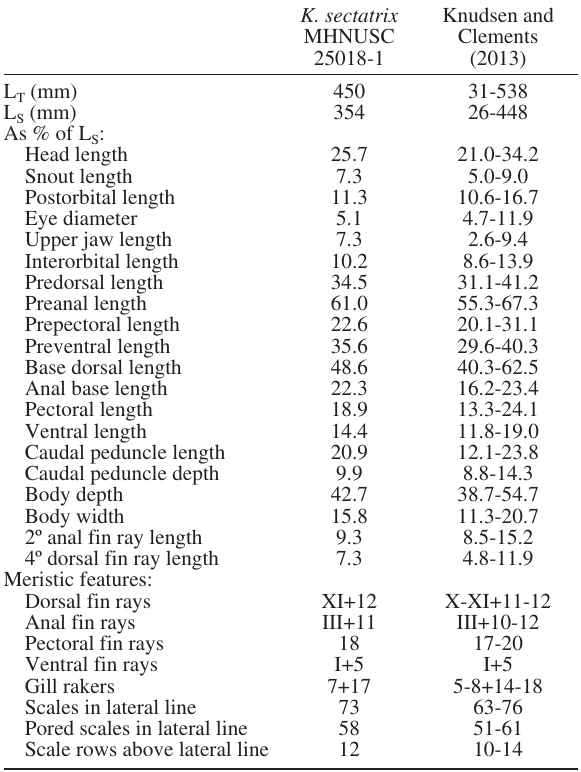
Table 2. – Morphometric and meristic data of the K. sectatrix speci- men caught in Galician waters.